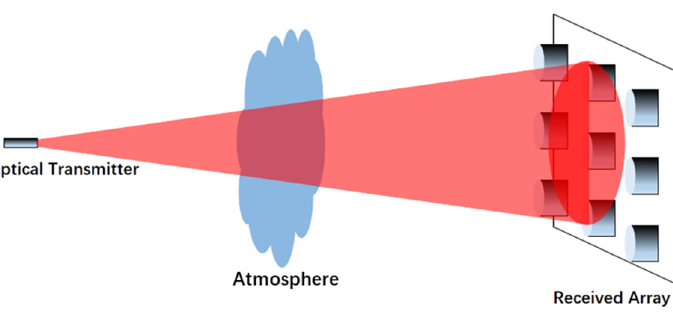
Figure 8. Schematic diagram of the spatial diversity receiving structure for SIMO FSO communications.